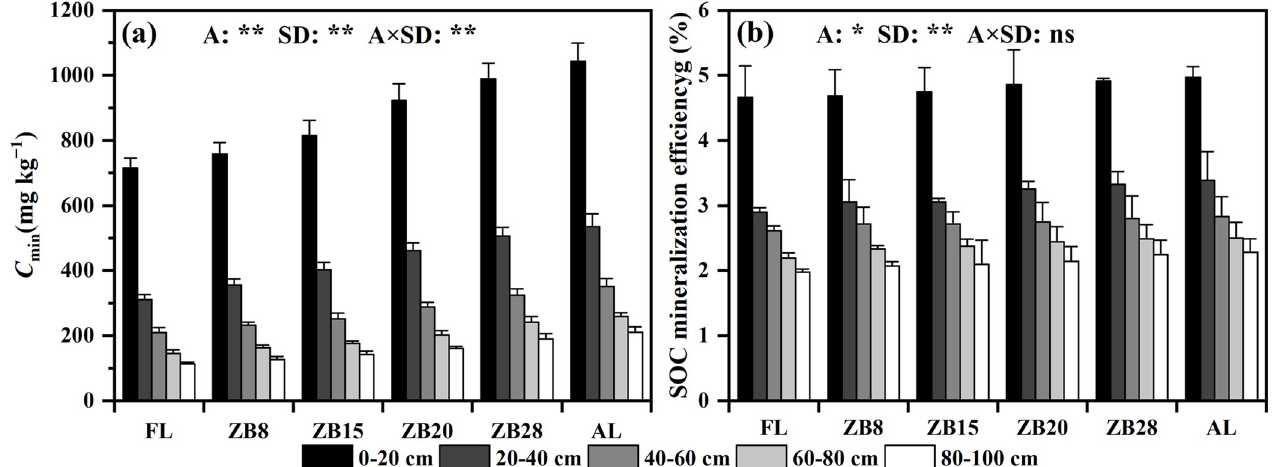
Fig 2. C min (a) and SOC mineralization efficiency (b) for farmland conversion in Arid Valley in soils over the incubation period. Error bars represent standard deviations ( n = 3). Significant differences for main effects of sites (A), soil depth (SD) and their interactions are shown at � : p < 0.05, �� : p < 0.01, ns: p > 0.05.